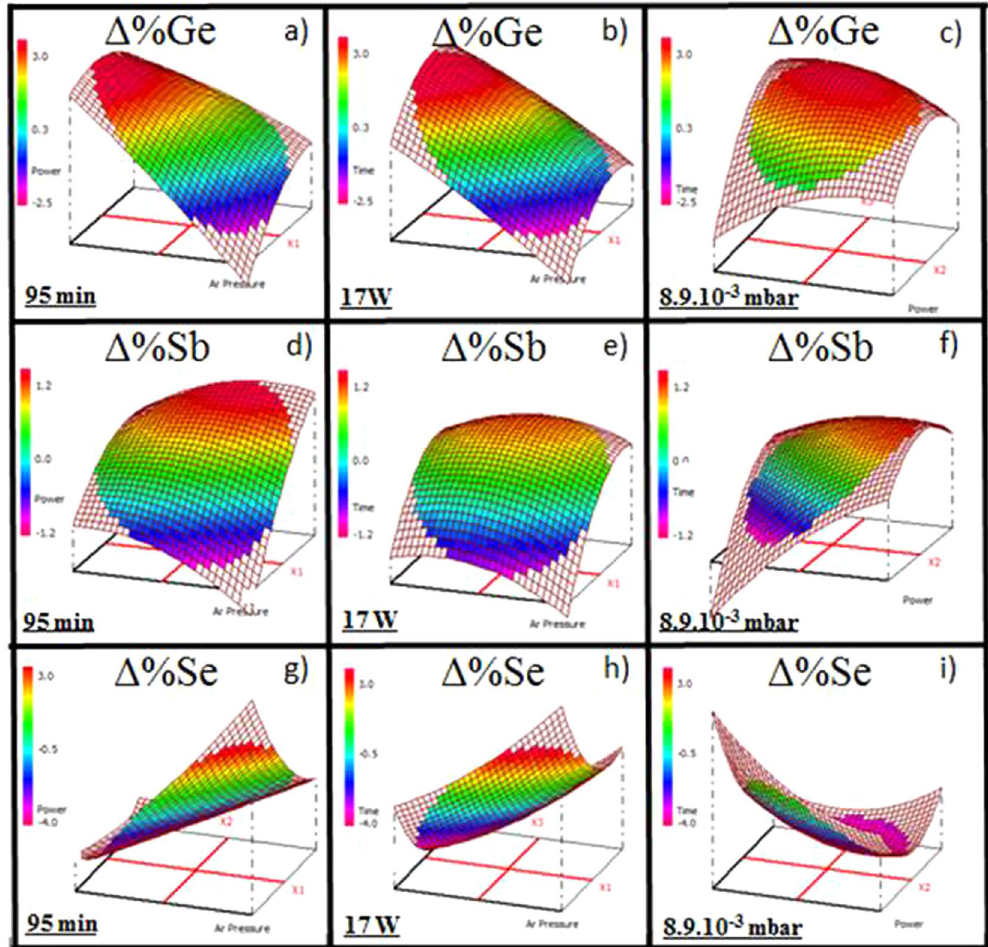
Figure 1. Variation of the chemical composition of the Ge 28.1 Sb 6.3 Se 65.6 thin films for a fixed deposition time 95 min ( a ) Δ %Ge, ( d ) Δ %Sb, ( g ) Δ %Se, for a fixed working power 17 W ( b ) Δ %Ge, ( e ) Δ %Sb, ( h ) Δ %Se, for a fixed Ar pressure 8.9.10 − 3 mbar ( c ) Δ %Ge, ( f ) Δ %Sb, ( i ) Δ